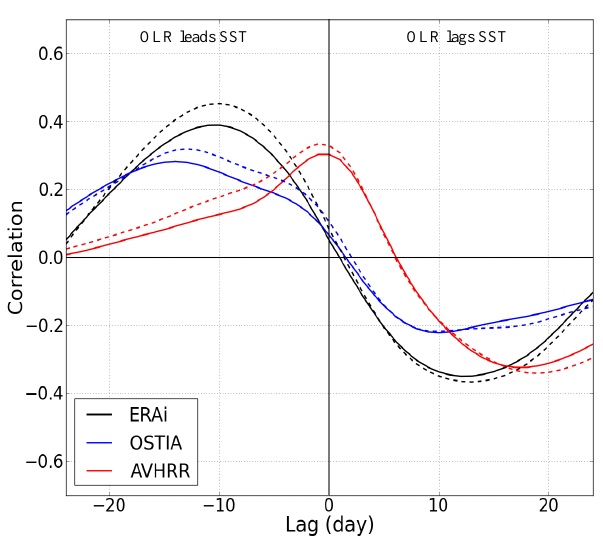
Fig. 7. Lag correlation coefficient between OLR and SST anomalies over the region 5 ◦ S–5 ◦ N, 60 ◦ –95 ◦ E over the winters (December– February) 1985–2006 using SST fields from ERA interim (ERAi, black lines), OSTIA (blue lines) and AVHRR (red lines) and OLR fields from either ERA interim (solid lines) or NOAA satellites (dashes lines). The lags are in days. OLR leads SST for negative lags and OLR lags SST for positive